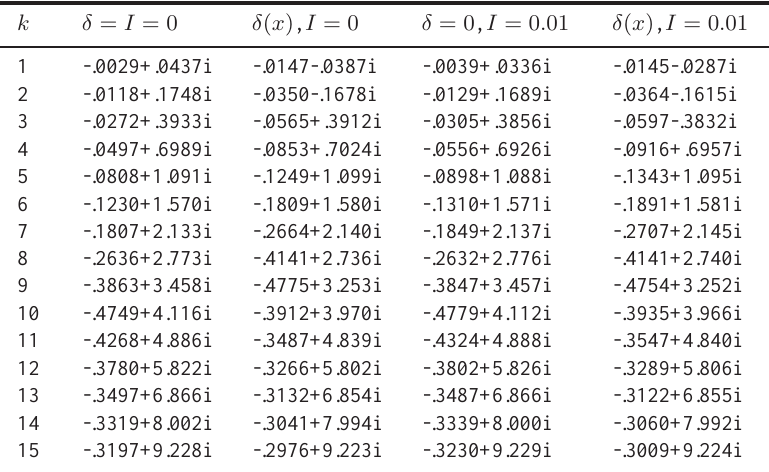
Table 1. The first 15 eigenvalues ¯ λ ( k ) for matrix G .